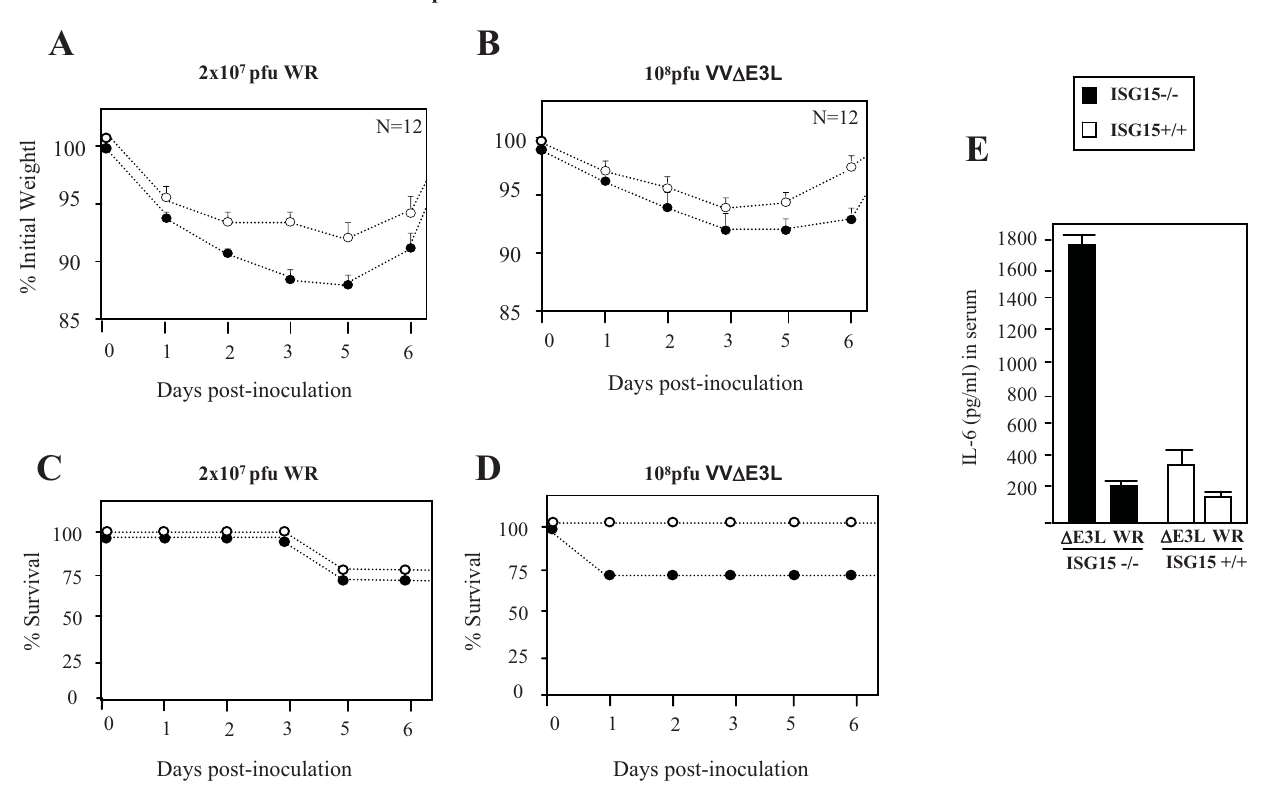
Figure 6. Virulence of WR or VV D E3L after infection of ISG15 + / + and ISG15 2 / 2 mice. A–B . Mice were inoculated i.p with purified VACV (2 6 10 7 PFU/mouse) or VV D E3L (10 8 PFU/mouse). Mice were individually weighed daily, and mean percentage weight loss of each group (n=12) was compared with the weight immediately prior to infection. C–D . Survival rate after i.p inoculation with both viruses. Dead animals were scored daily and represented as the percentage of surviving animals. P # 0.01 in all experiments. E . IL-6 measured by ELISA from serum collected at 3 hpi. Results represent the mean 6 SD of pooled samples from 6 mice.